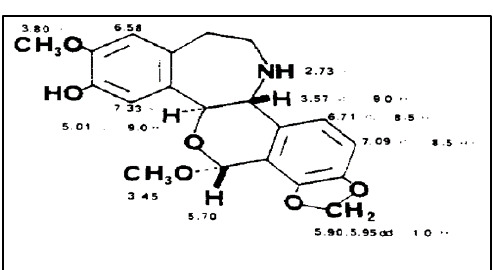
spectrum for Papaverrubine alkaloid 285 nm (15)